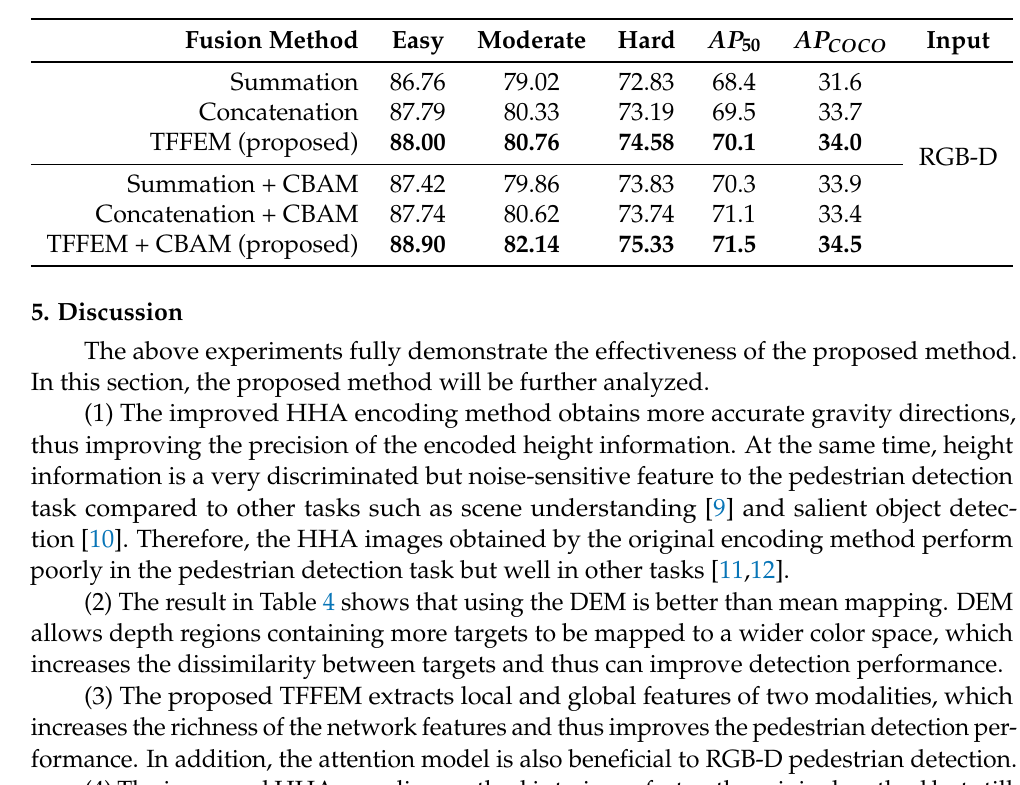
Table 5. Comparison of fusion methods on the KITTI val dataset for RGB-D pedestrian